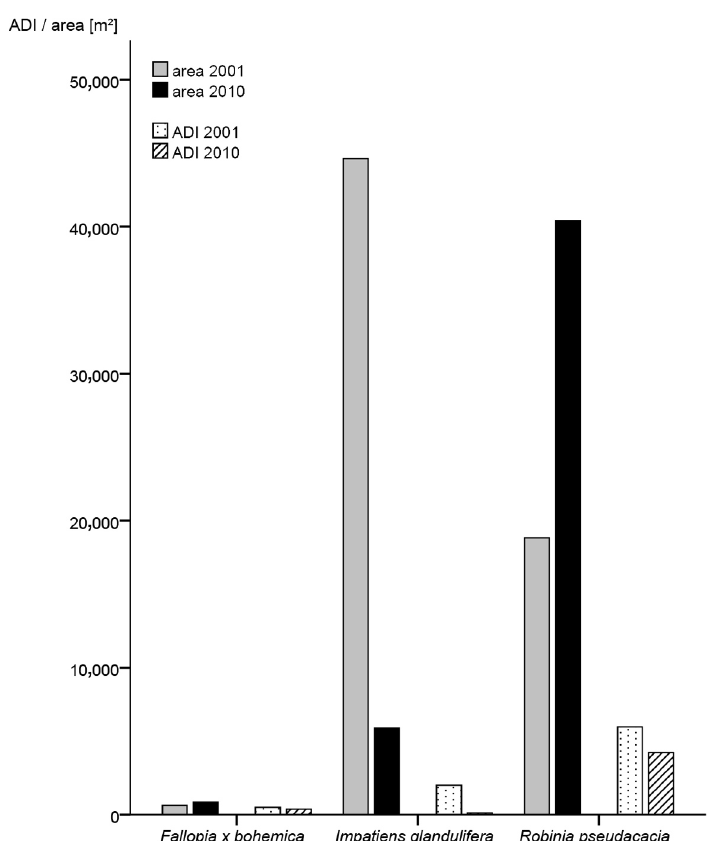
Figure 3. Total invaded area [m 2 ] and Area-Density-Index (ADI) of Fallopia × bohemica , Impatiens glan- dulifera and Robinia pseudoacacia in the first (2001) and second survey (2010) in the Austrian part of the National Park